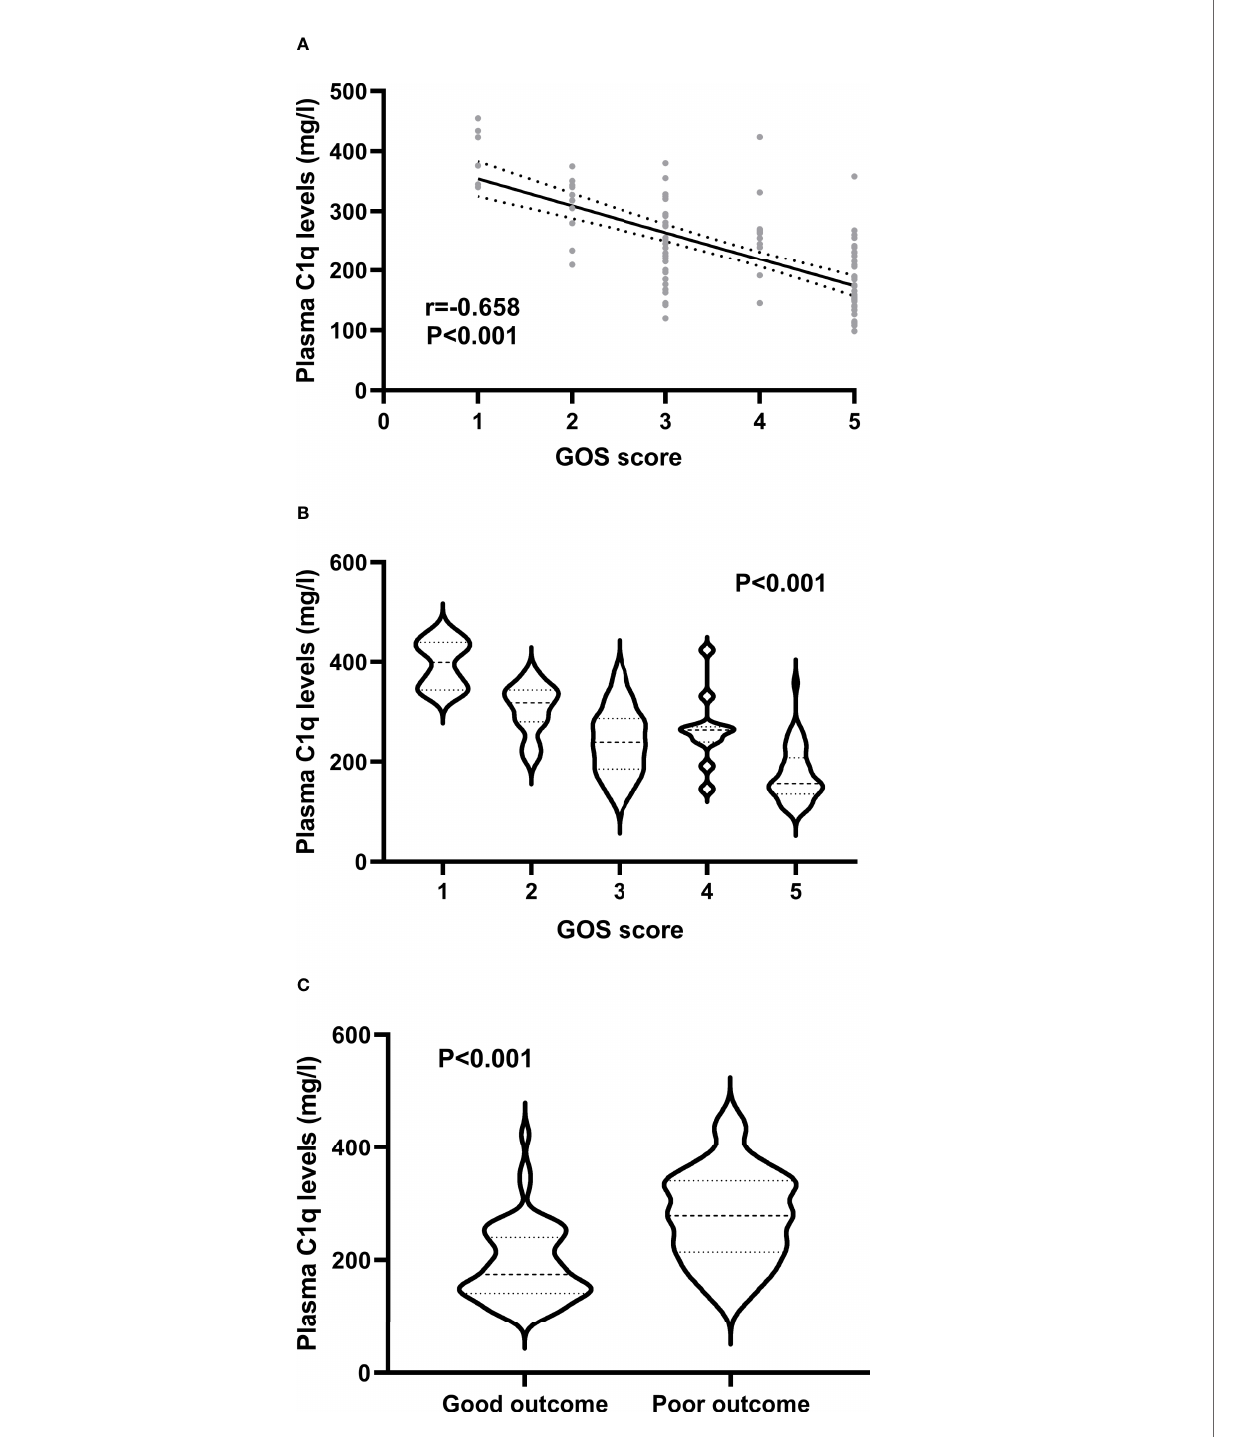
FIGURE 4 | Association of plasma C1q levels with prognosis at 3 months after acute intracerebral hemorrhage. (A) Association of plasma C1q levels with Glasgow Outcome Scale score after intracerebral hemorrhage. Plasma C1q levels were highly correlated with Glasgow Outcome Scale score after stroke using the Spearman ’ s correlation coef fi cient (P < 0.001). GOS means Glasgow Outcome Scale. (B) Differences of plasma C1q levels by Glasgow Outcome Scale score after acute intracerebral hemorrhage. There were substantial differences in terms of plasma C1q levels after stroke among multiple groups using the Kruskal-Wallis test (P < 0.001). GOS denotes Glasgow Outcome Scale. (C) Differences of plasma C1q levels between patients with Glasgow Outcome Scale score 1-3 and those with Glasgow Outcome Scale score 4-5 at 3 months after stroke. Plasma C1q levels were markedly raised in patients with Glasgow Outcome Scale score 1-3, as compared to those presenting with score 4-5 at 3 months after stroke using the Mann – Whitney U test (P <